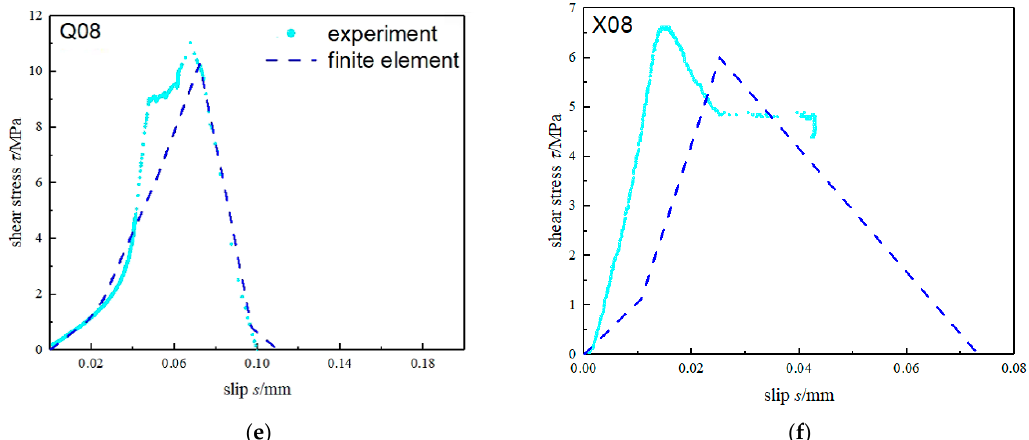
Figure 7. Comparison of Bond–Slip Curve between Different Groups. ( a ) Q-01; ( b ) X-01; ( c ) Q-05; ( d ) X-05; ( e ) Q-08; ( f ) X-08.